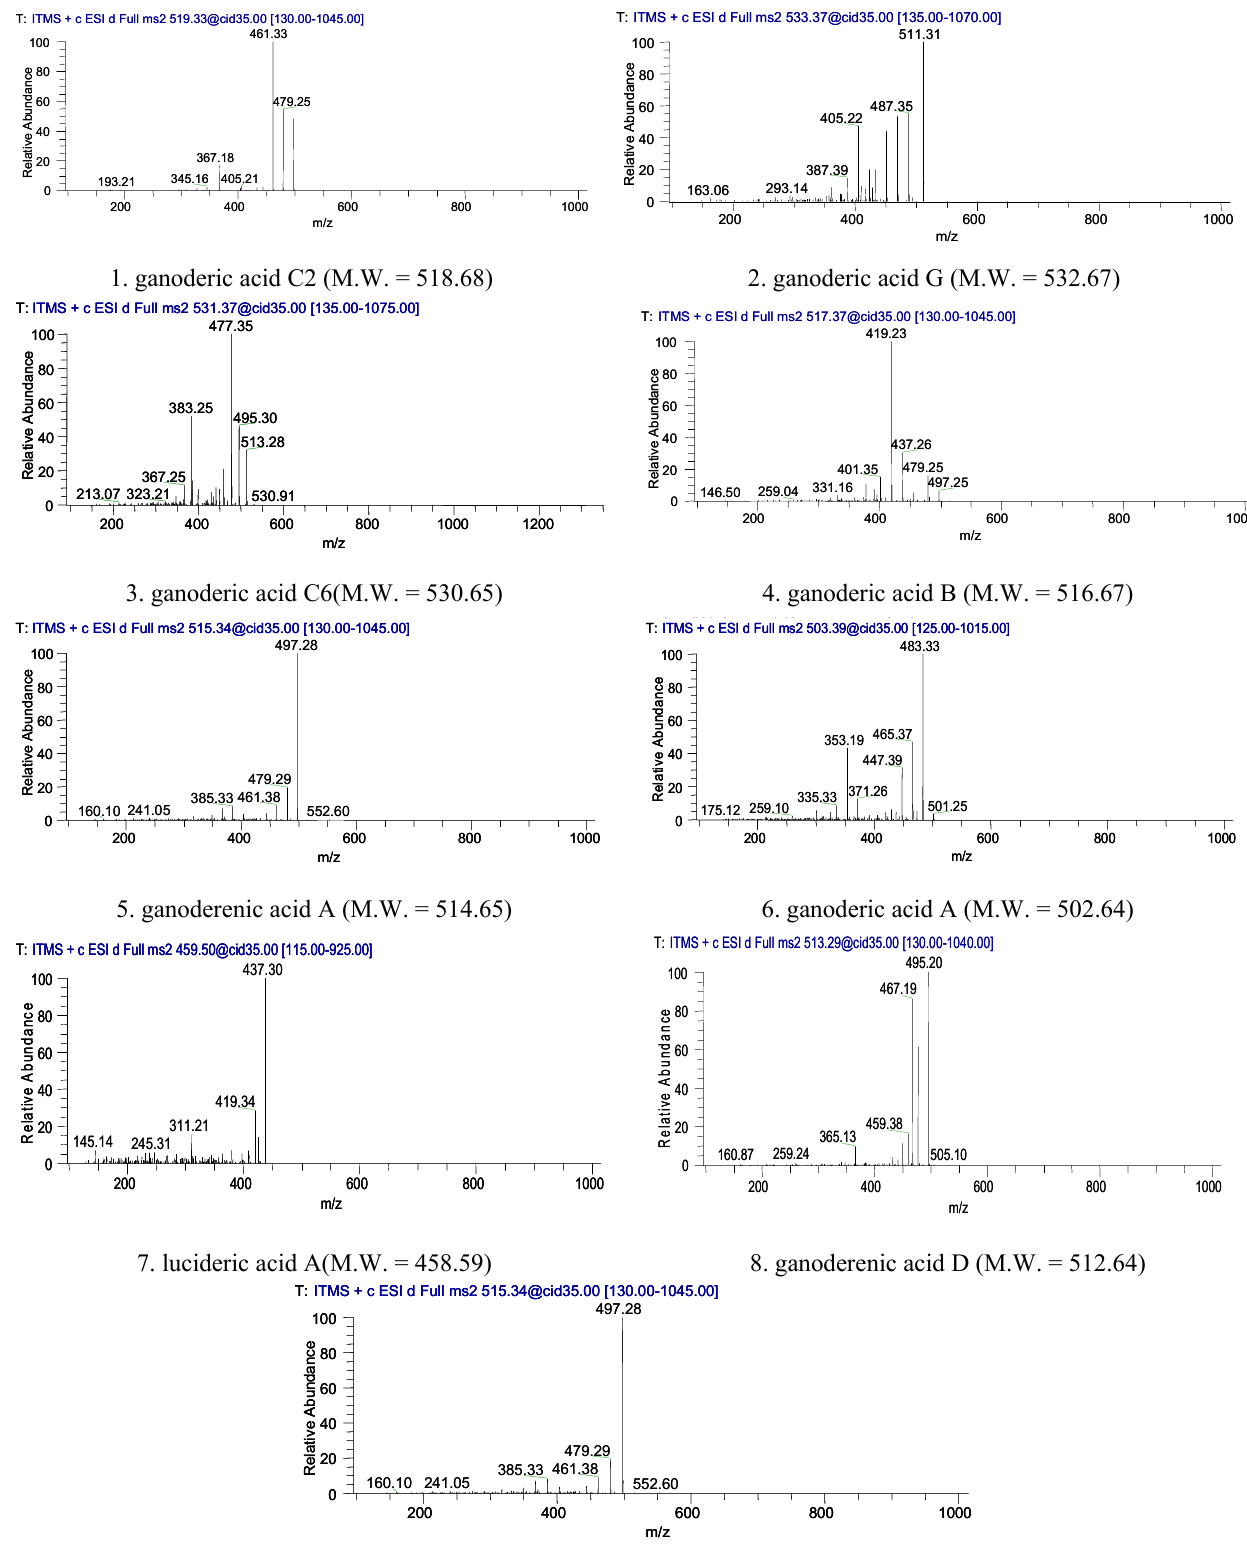
Figure 3. The MS 2 of LC/MS ion fragmentation of triterpenes of